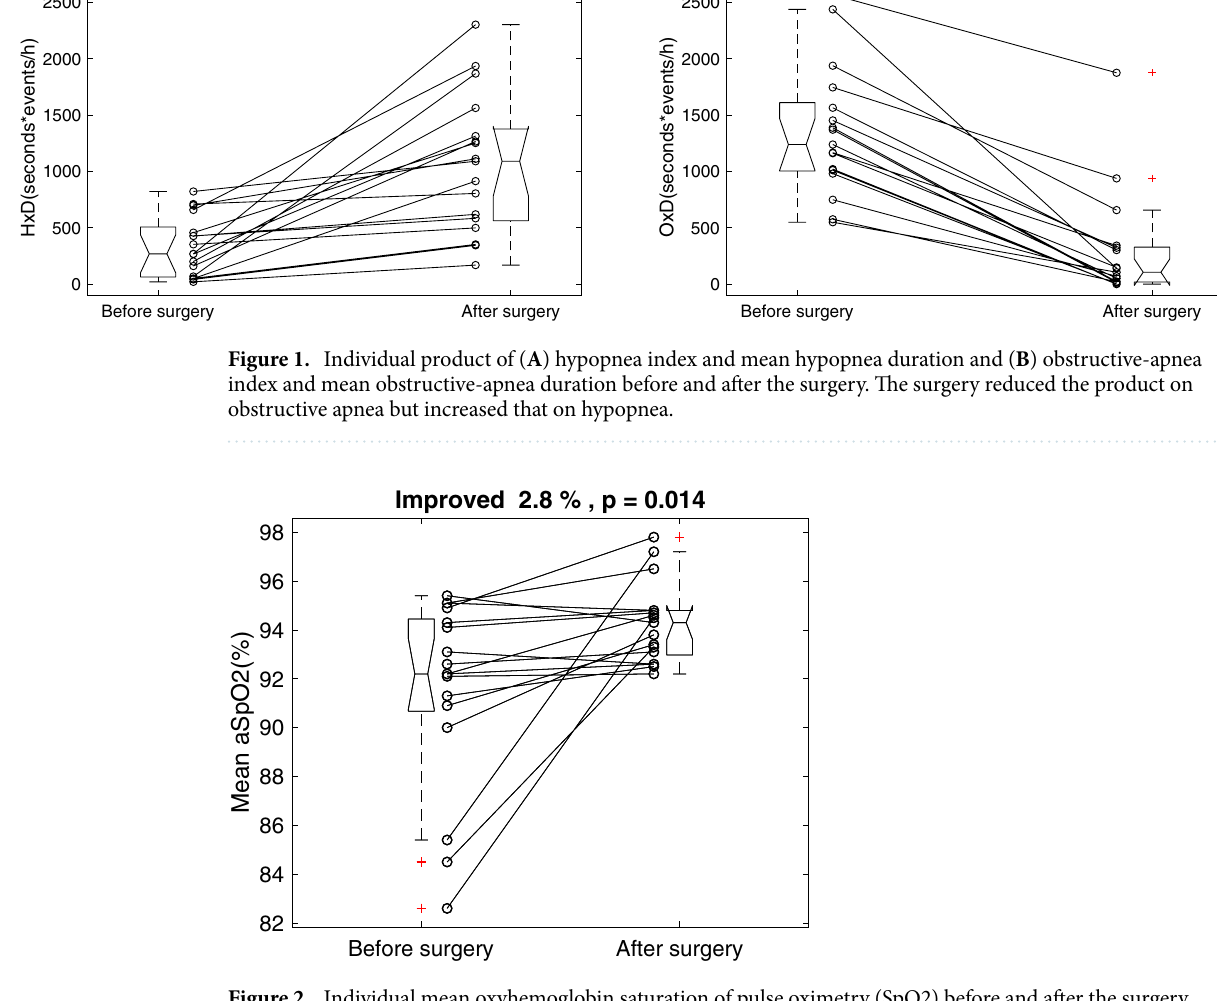
Figure 2. Individual mean oxyhemoglobin saturation of pulse oximetry (SpO2) before and after the